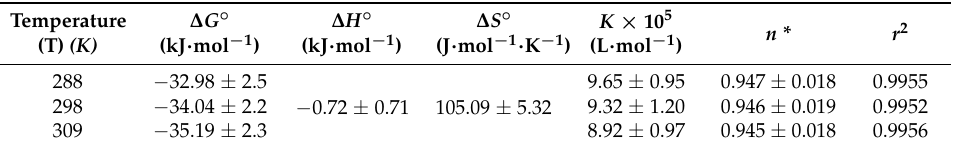
Table 2. Summary of the thermodynamic parameters for the compound 3 -BSA interaction along with binding parameters K and n.